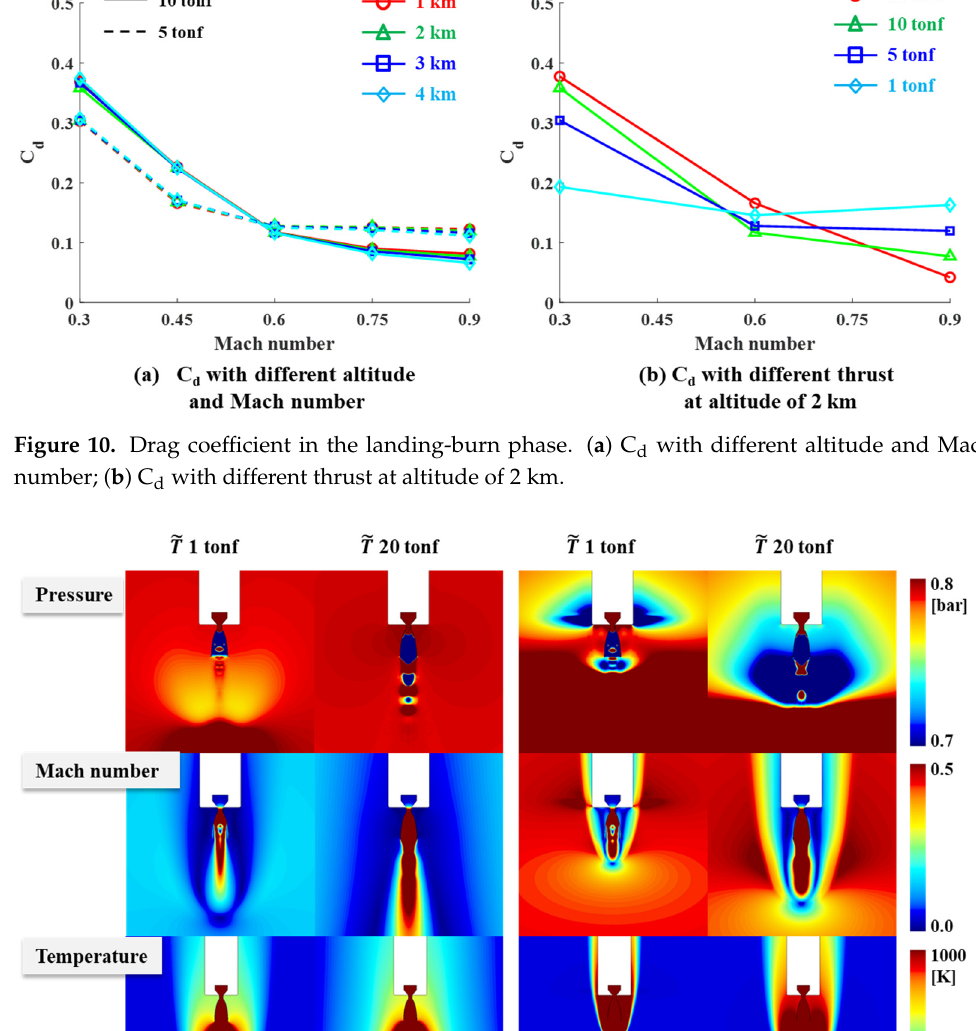
Figure 12. Cd prediction using different Mach numbers and thrust values.